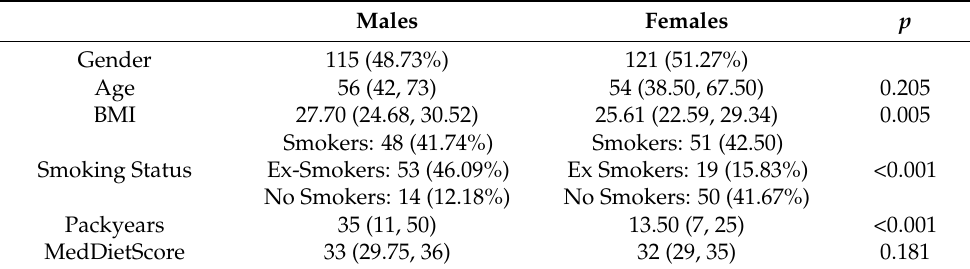
Table 1. Demographic Characteristics of the Study